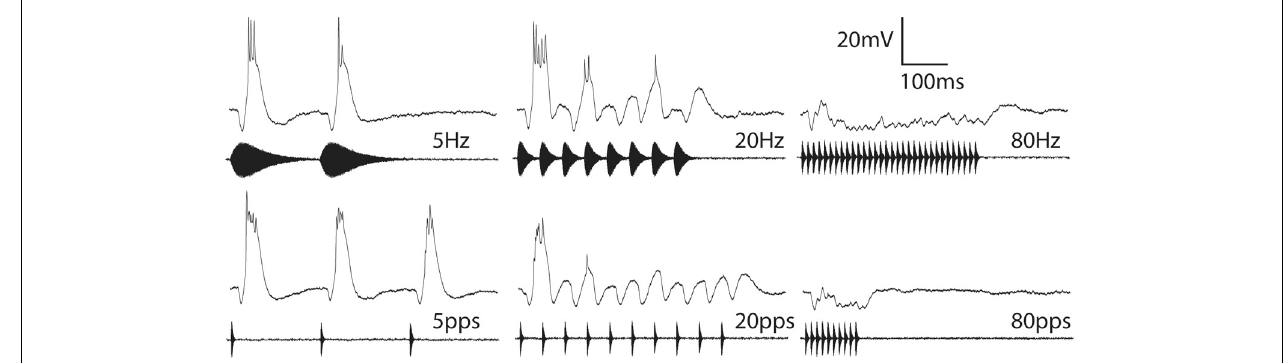
FIGURE 3 | Averaged responses from a long-interval neuron to stimuli in which pulse duration varied (top) or was held constant at 10ms (bottom) across AM rates (Hz) or pulse rates (pulses/s) of 5, 20 or 80. Resting potential = − 69mV; BEF = 1300Hz; 53dB SPL. Adapted from (Edwards et al.,